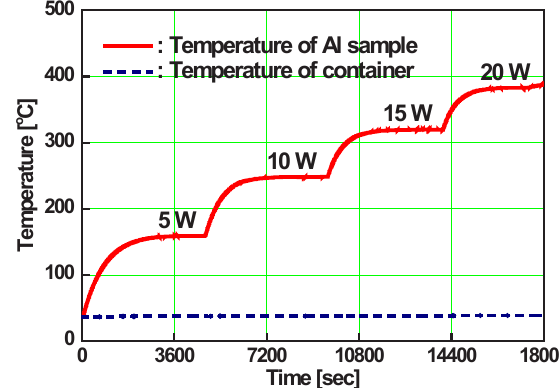
Fig. 3. Whole trends of the temperature changes of the Al sample and the container in the calibration experiment for the high electric power